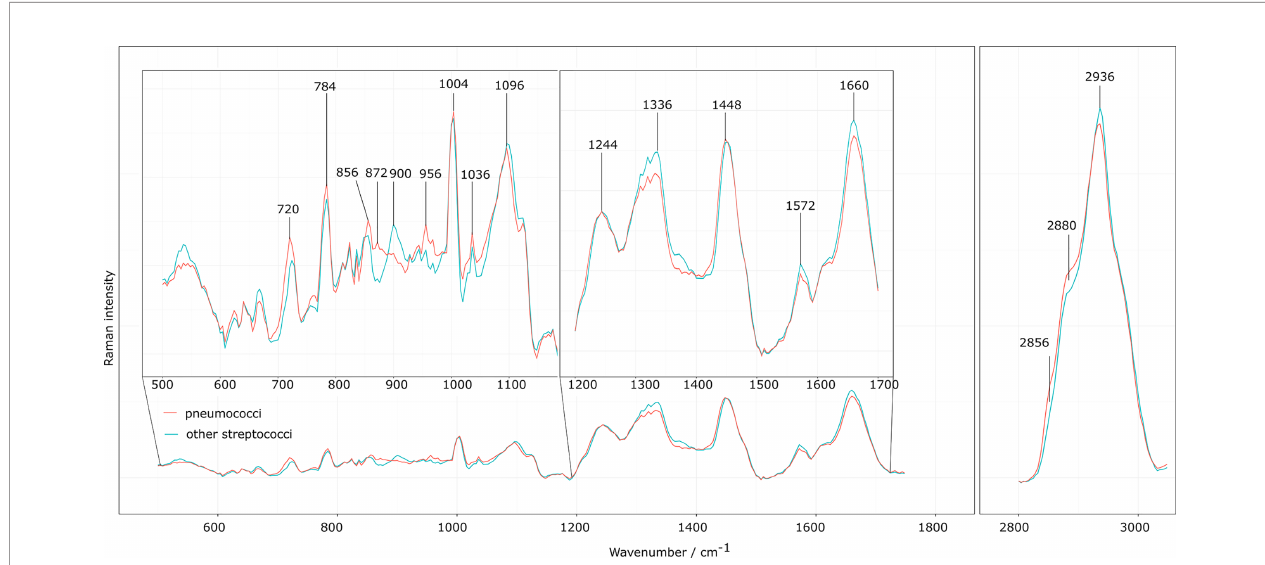
FIGURE 1 | Raman mean spectra of the laboratory strains. Preprocessed Raman mean spectra of the eight different S. pneumoniae strains (orange) and the four different non-pneumococcal Streptococcus species (turquois) presented as overlaid spectra to visualize spectral differences. The insets highlight Raman bands of interest discussed in the corresponding assignment in Table 2